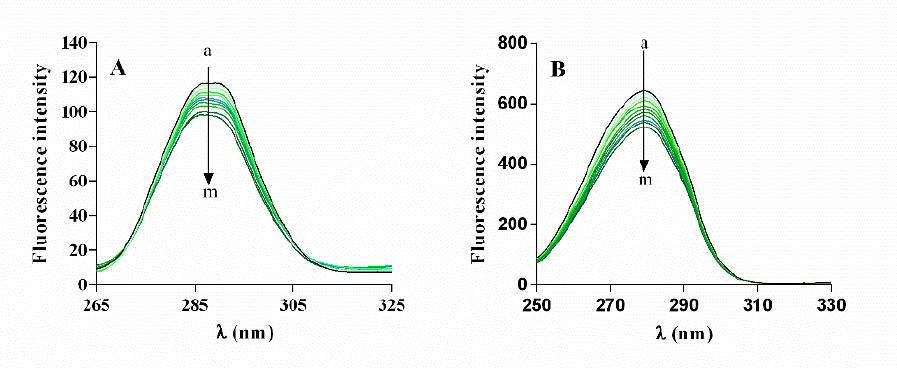
Figure 8. Synchronous fluorescence spectra of α - glucosidase with increasing α -mangostin concen- trations (pH 6.8, T= 298 K) at ∆λ=15 nm ( A ) and ∆λ=60 nm ( B ). Concentrations of the inhibitor (a m): 0.0, 0.05, 0.15, 0.25, 0.35, 0.45, 0.60, 0.75, 1.0, 1.25, and 1.5 µM.